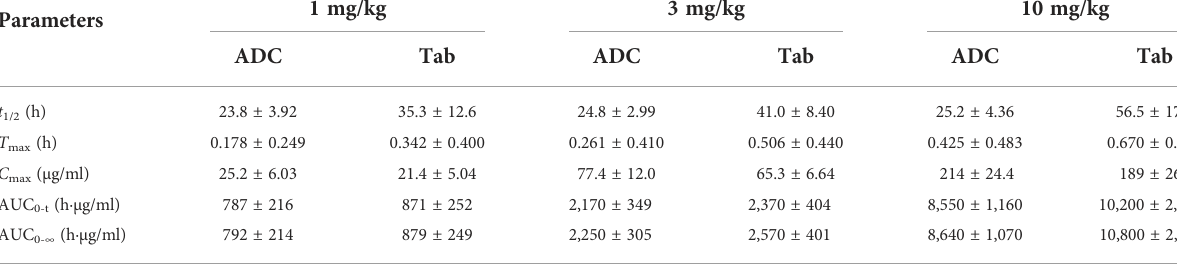
TABLE 2 Serum pharmacokinetic parameters of ADC and Tab after administration of SKB264 in cynomolgus monkeys (mean ± SD).